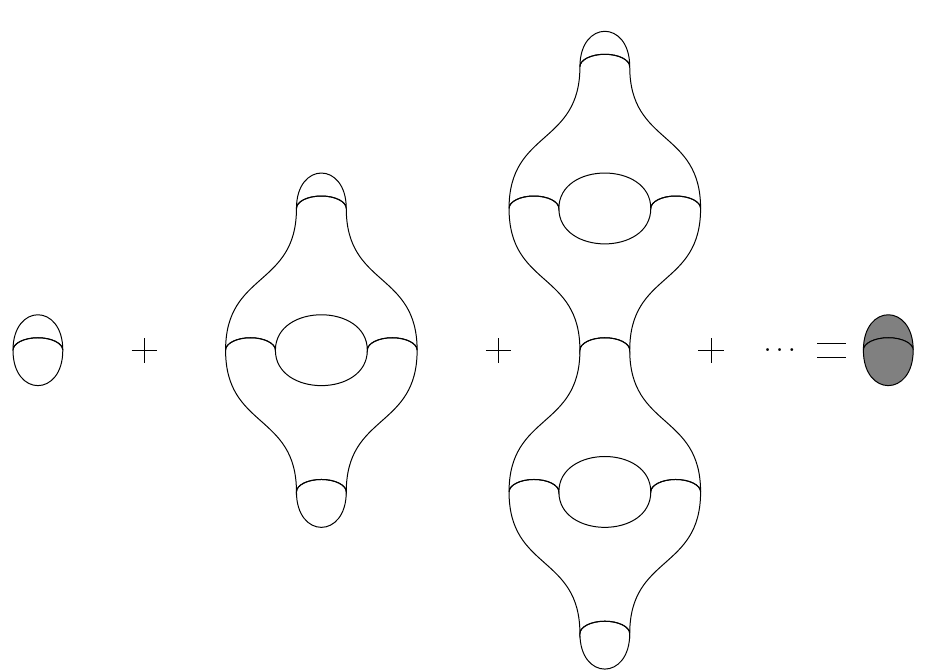
Figure 2 . The definition of λ as the sum of connected bordisms X : ∅ → ∅ with an arbitrary number of handles (we will henceforth use shading as in the bordism on the right hand side to indicate such a sum over all connected